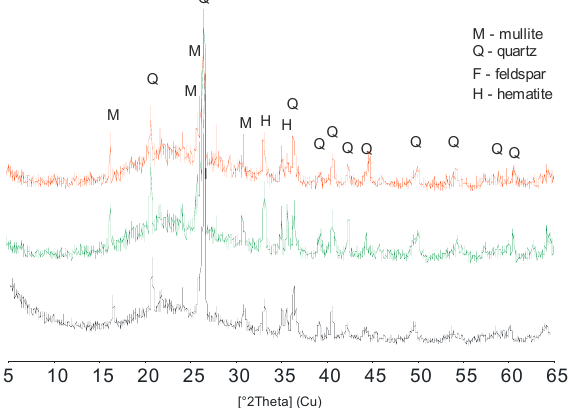
Figure 3. XRD patterns of the lightweight aggregates (LWAs): CLAY ( black ), CLIN ( green ) and NAP1 ( red ).